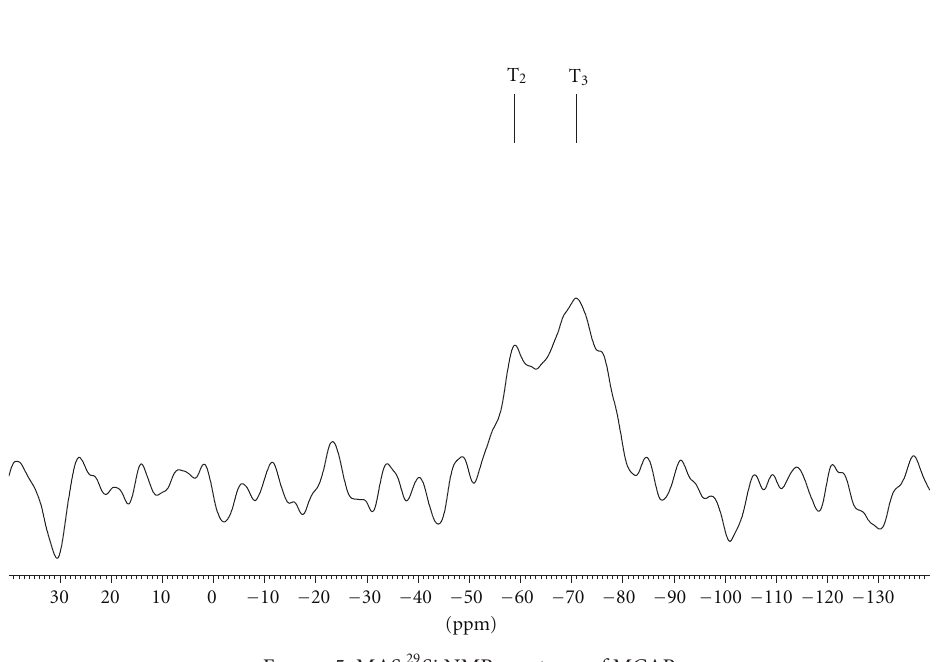
Si NMR spectrum of